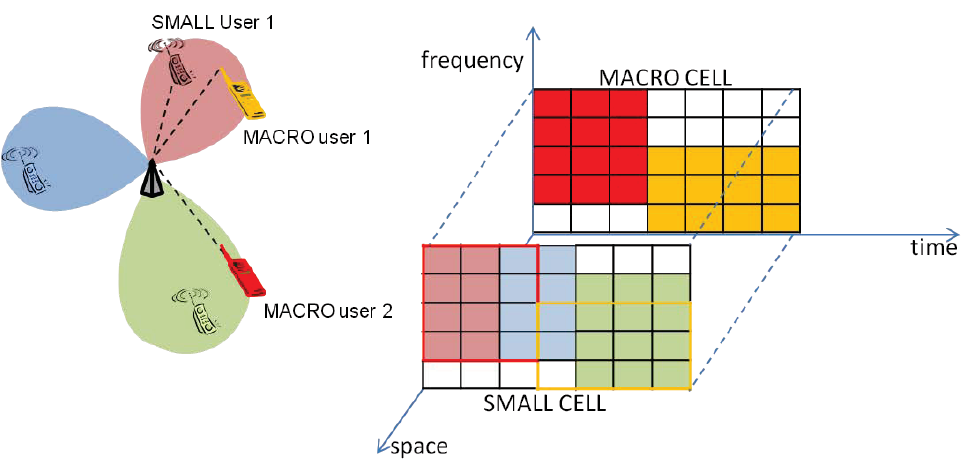
Figure 3. Cognitve Beamforming and Resource allocation.